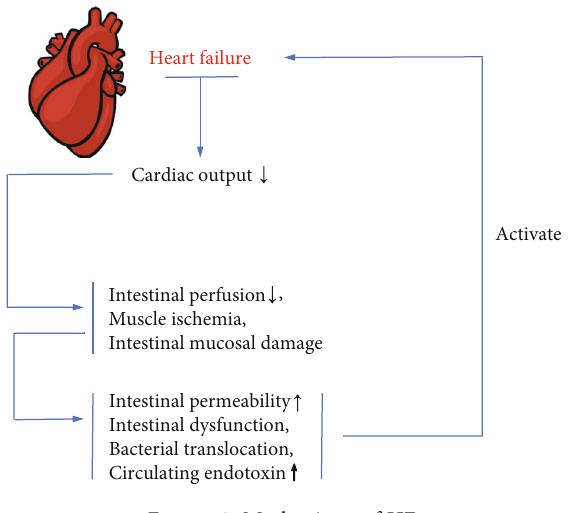
Figure 2: Mechanisms of